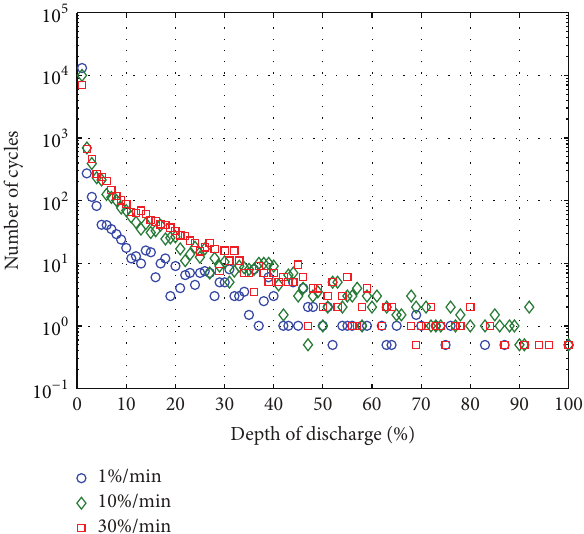
Figure 12: Observed number of storage charge-discharge cycles as a function of the depth of discharge for compensating two different generator sizes complying to a ramp rate limit of 10%/min during the year 2012. The depth of discharge is calculated with respect to the observed effective energy capacity requirements shown in Figure